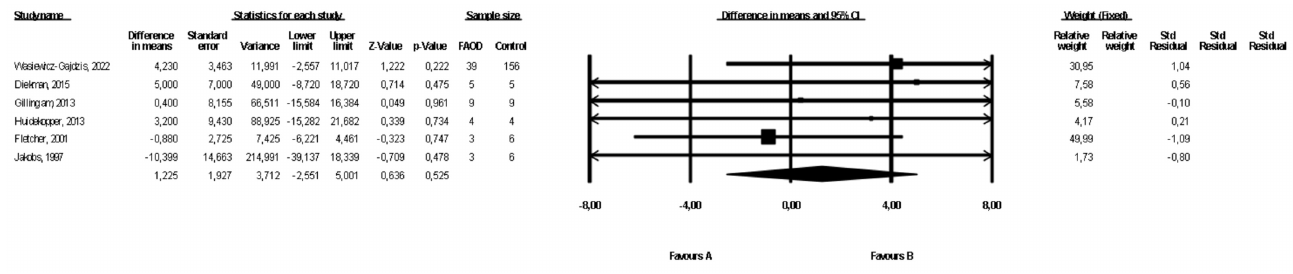
Figure 2. Forest plot—comparison of body weight in FAOD patients vs. controls [16,18,19,21,22].